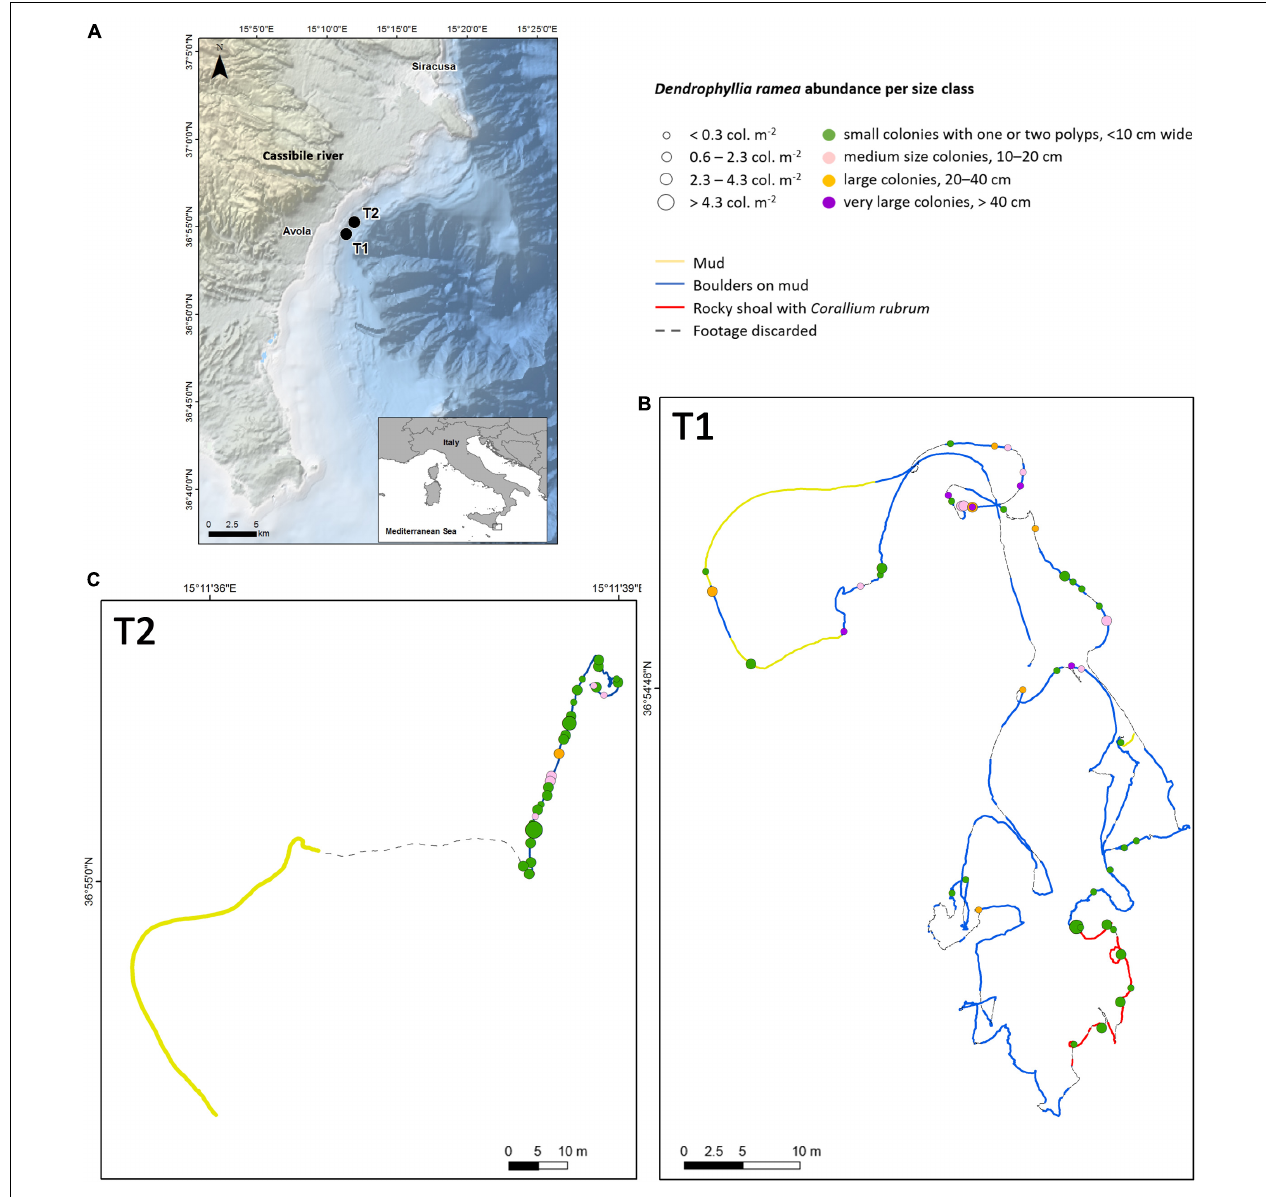
FIGURE 1 | Investigated area: (A) Apollo Bank. Black dots represent the locations of the two remotely operated vehicle (ROV) tracks where Dendrophyllia ramea was found. Background bathymetry was obtained from EMODnet. (B,C) ROV track for each exploratory dive with the location of relative coral range abundance per size class and an indication of the type of